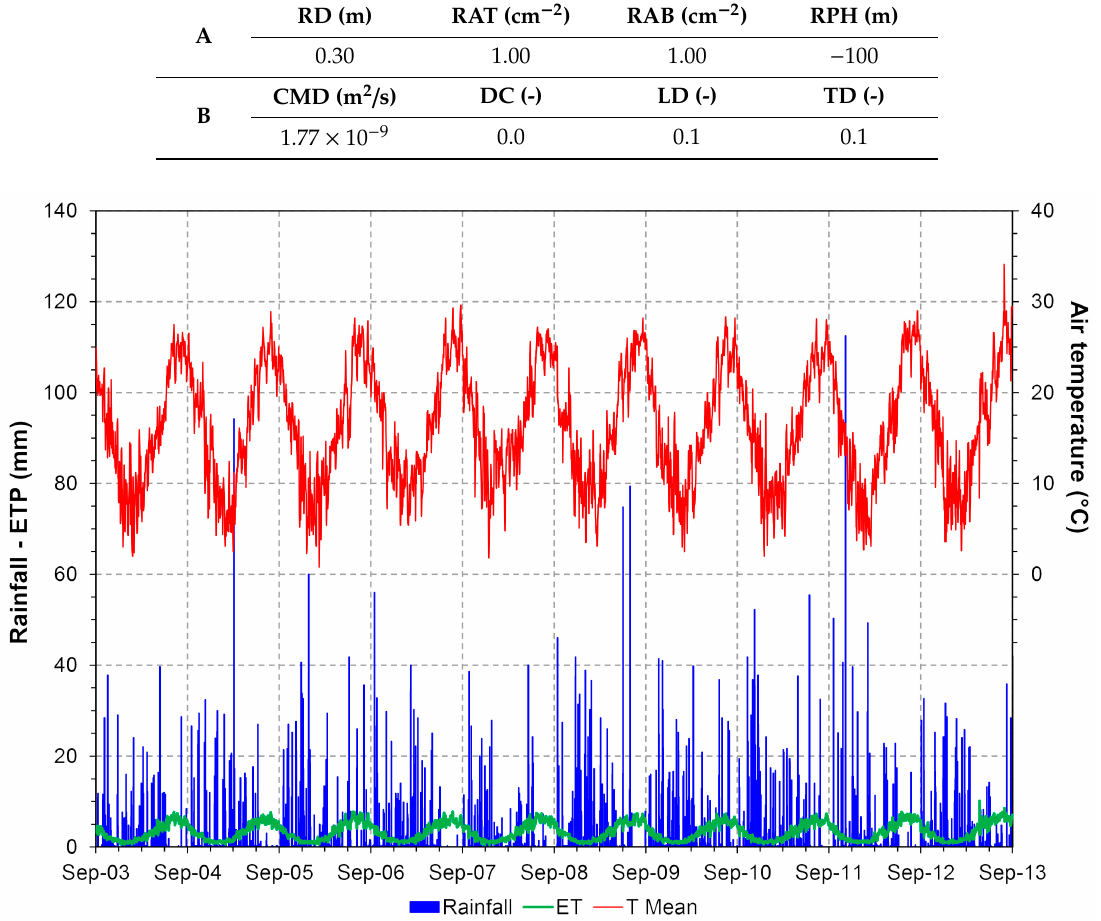
Figure 3. Daily rainfall and evapotranspiration rates (from the beginning of September 2003 to the end of August 2013) applied as climate boundary conditions to VS2DTI modeling.